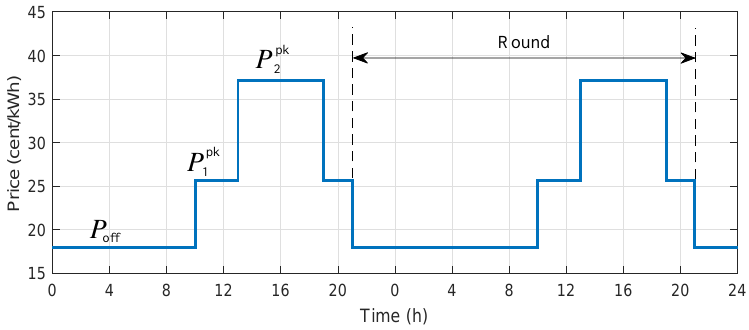
Figure 2. Residential time-of-use tariff provided by PG&E